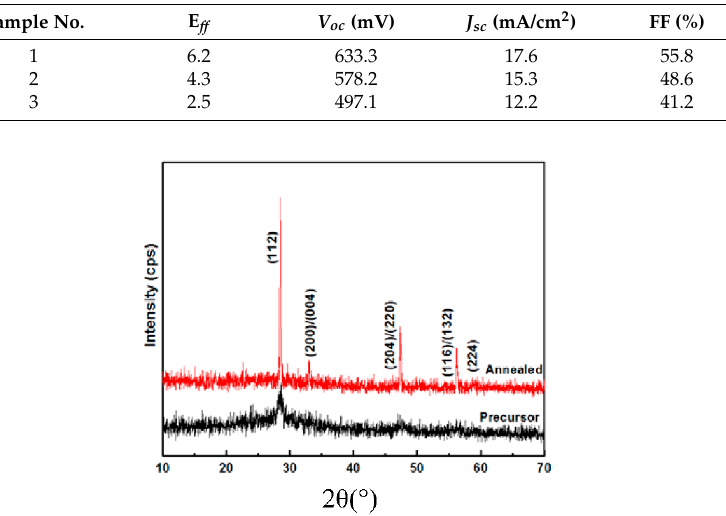
Nanomaterials 2019 , 9 , x FOR PEER REVIEW Figure 7. XRD of precursor and annealed CZTS film. Figure 7. XRD of precursor and annealed CZTS film.